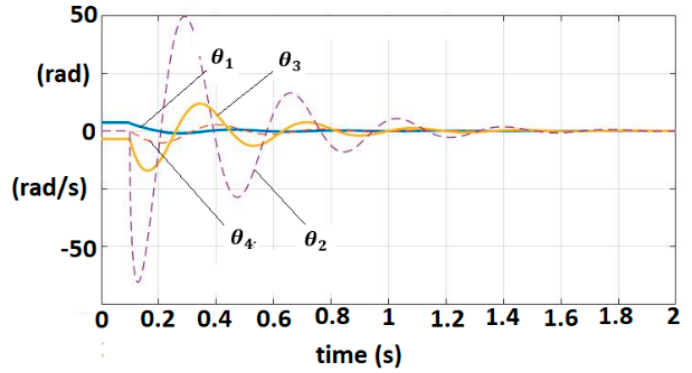
Figure 9. Fractional-order variable trajectories for FOM EXHAND with delay.